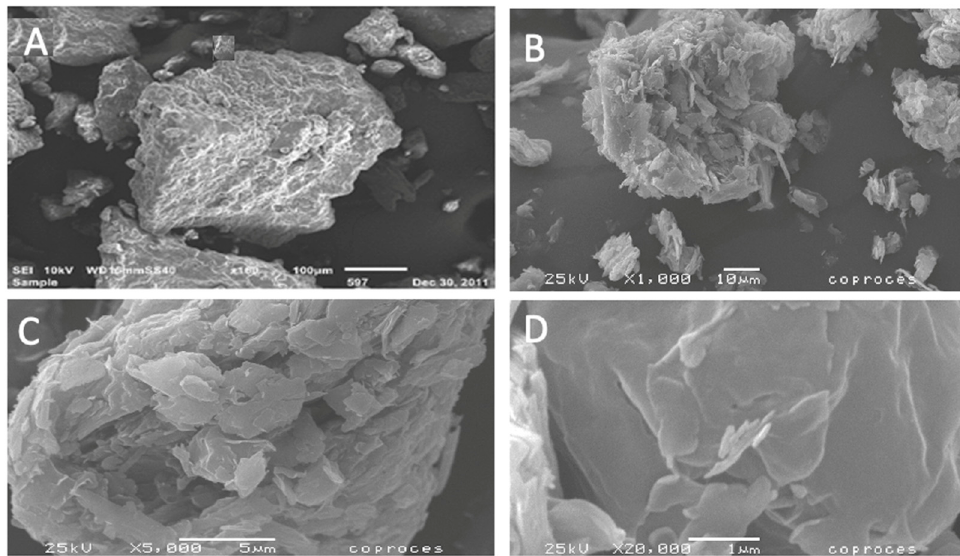
Figure 1. SEM photographs of ( A ) Di-Tab, ( B ) batch 3 1000x, ( C ) batch 3 5000x, and ( D ) batch 3 20000x.